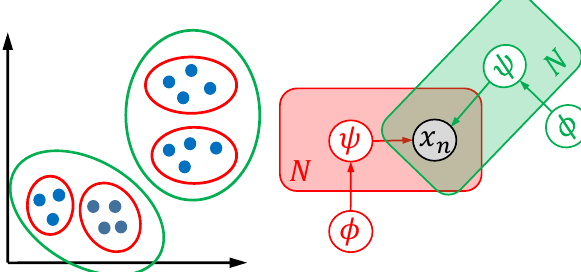
Figure 1. Two-dimensional representation of a specimen dataset and two valid clusters unveiling the latent structure (left side). Two models (right side, red and green model) with global parameter Φ and local parameter Ψ may result in two or four